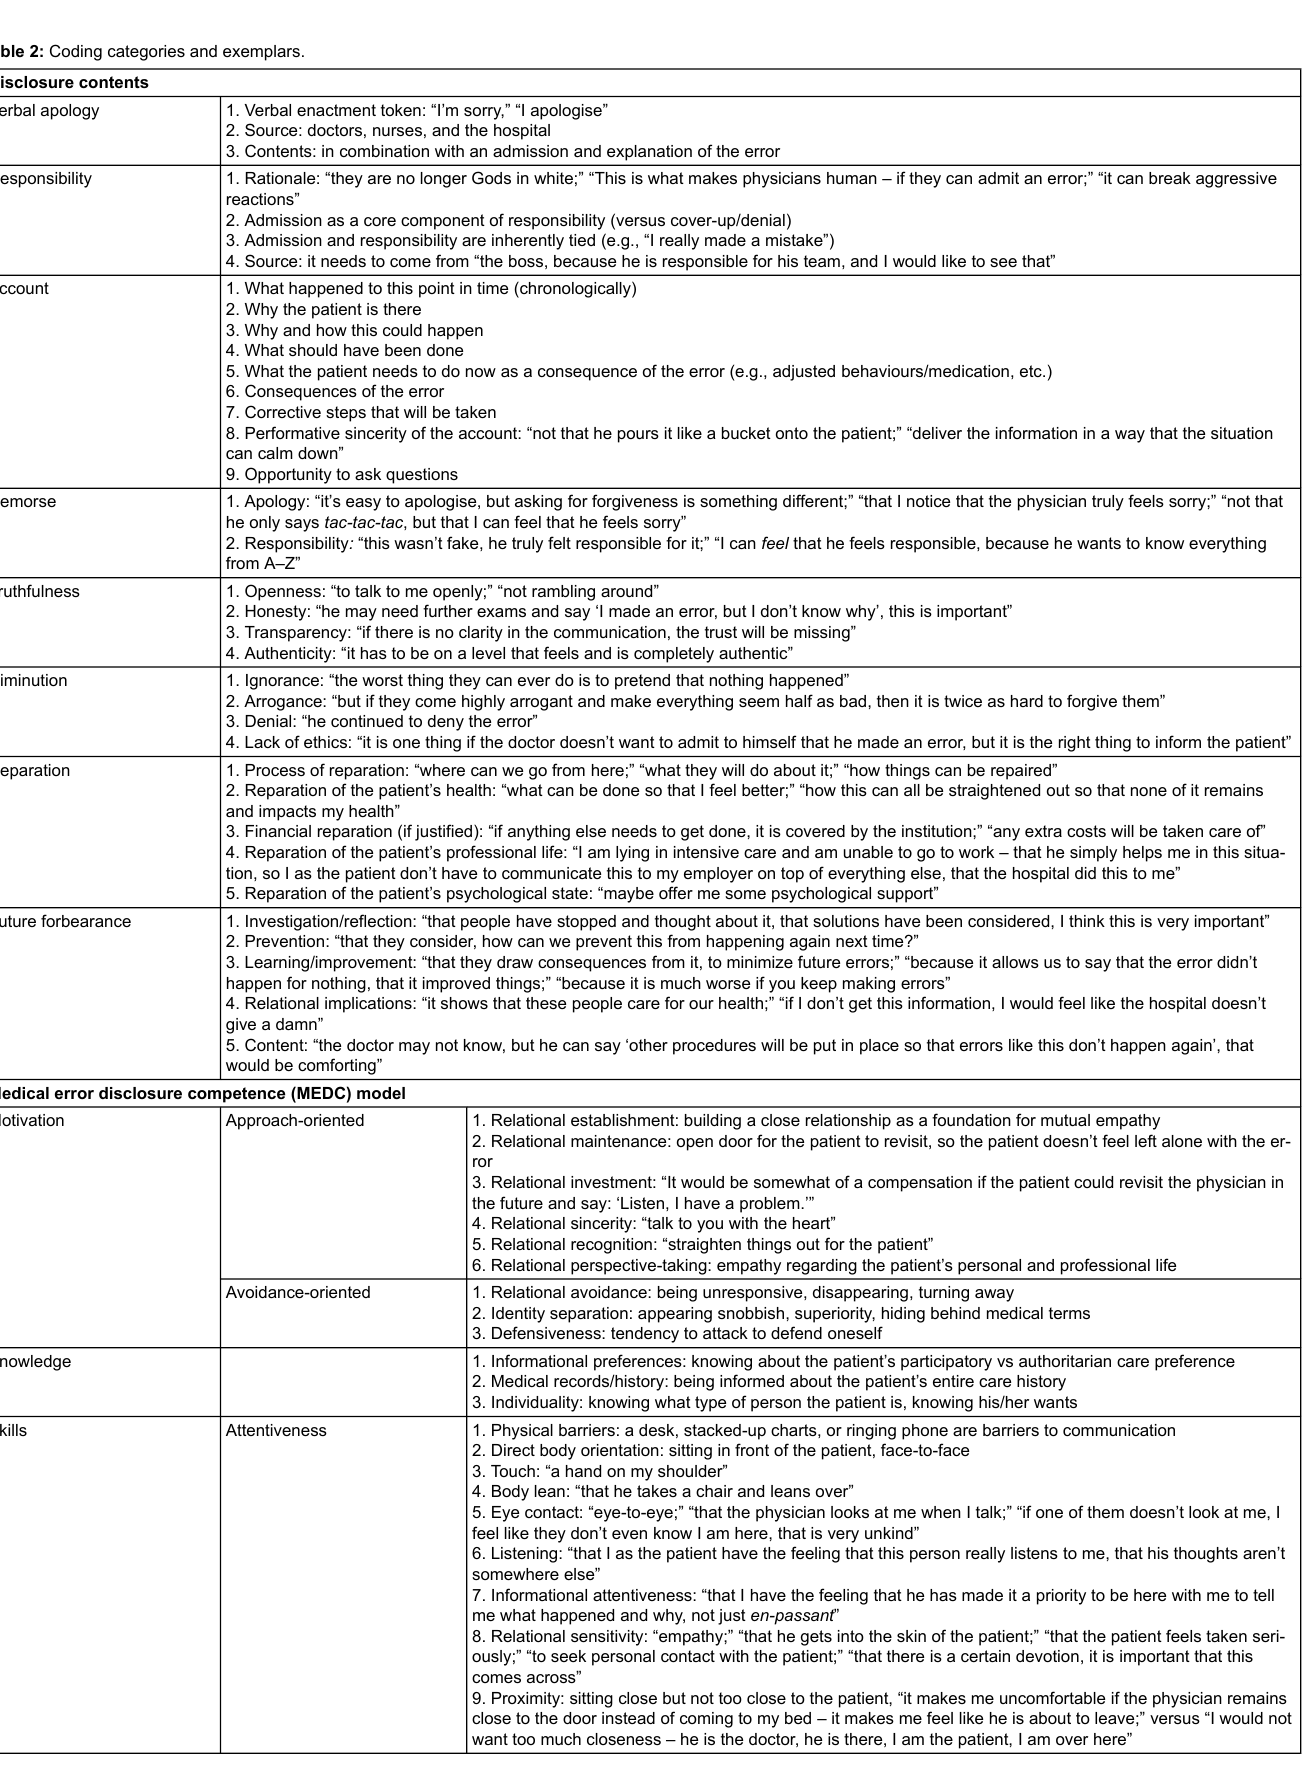
Table 2: Coding categories and